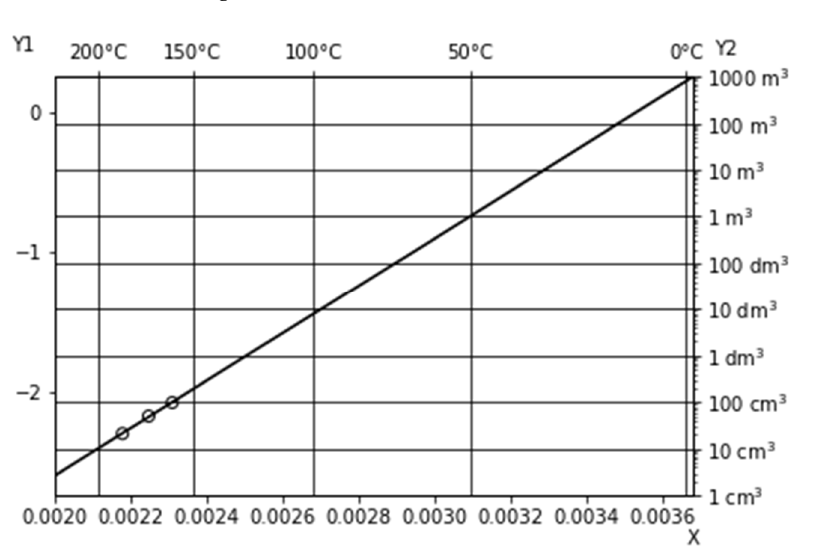
Figure 12. Pseudo-Arrhenius graph of the self-ignition temperature of the sludge pellets.